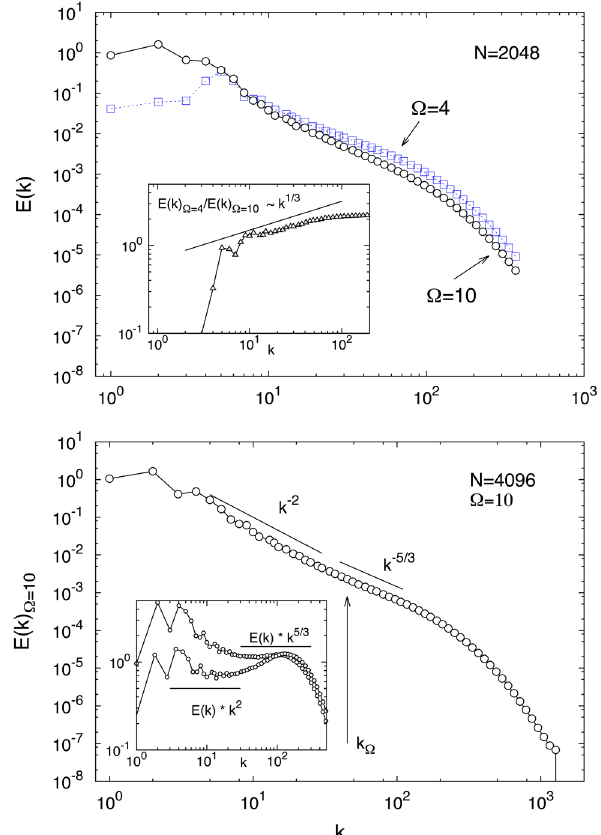
FIG. 4. Log-logplotsoftheenergyspectrum.Top:Spectraforthe runs at N ¼ 2048 . Data with Ro ¼ 0 . 76 and Ω ¼ 4 (squares) and data with Ro ¼ 0 . 25 and Ω ¼ 10 (circles). Inset: Effect of rotation on the forward energy cascade is highlighted in terms of the ratio of the two spectra, E Ω ð k Þ =E Ω ð k Þ ∼ k 1 = 3 . Bottom: Spectrum for ¼ 4 ¼ 10 N ¼ 4096 , Ro ¼ 0 . 25 , and Ω ¼ 10 ; the expected scaling behav- iors ∝ k − 2 and ∝ k − 5 = 3 , above and below the Zeman wave number k N ¼ 4096 Ω , respectively, are also plotted. Inset: Spectrum for and Ω ¼ 10 compensated with k − 2 and with k − 5 = 3